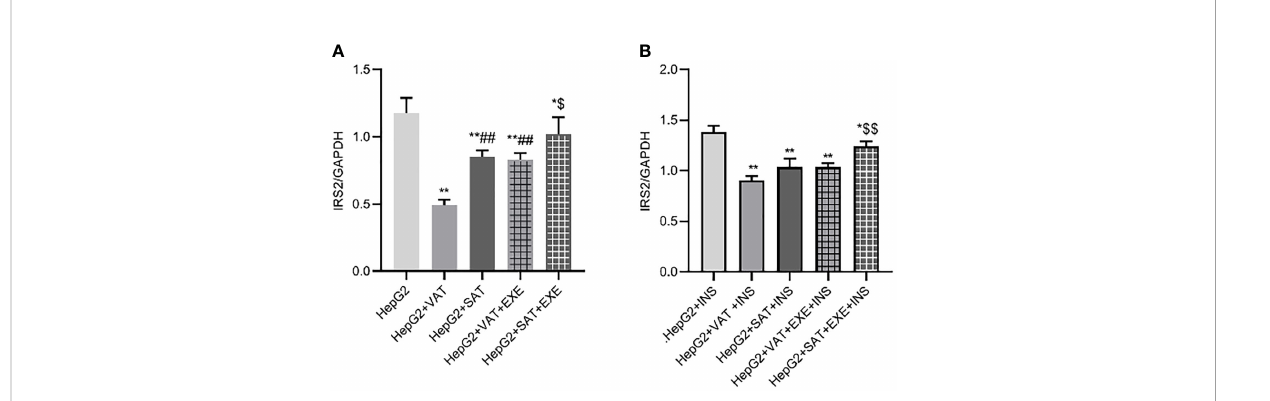
FIGURE 5 The in fl uence of exenatide on the expression of IRS2 protein in hepatocytes conducted by different regional adipose tissue. (A) Expression of IRS2 protein in HepG2 cells of each group. Data are means ± SEM, n = 3/group, *P < 0.05, **P < 0.01 vs. HepG2 group; ## P < 0.01 vs. HepG2 +VAT group; $ P< 0.05 vs. HepG2+SAT group. (B) Expression of IRS2 protein in HepG2 cells of each group under the action of insulin. Data are means ± SEM, n = 3/group, *P < 0.05, **P < 0.01 vs. HepG2+INS group; $$ P < 0.01 vs. HepG2+SAT+INS group.